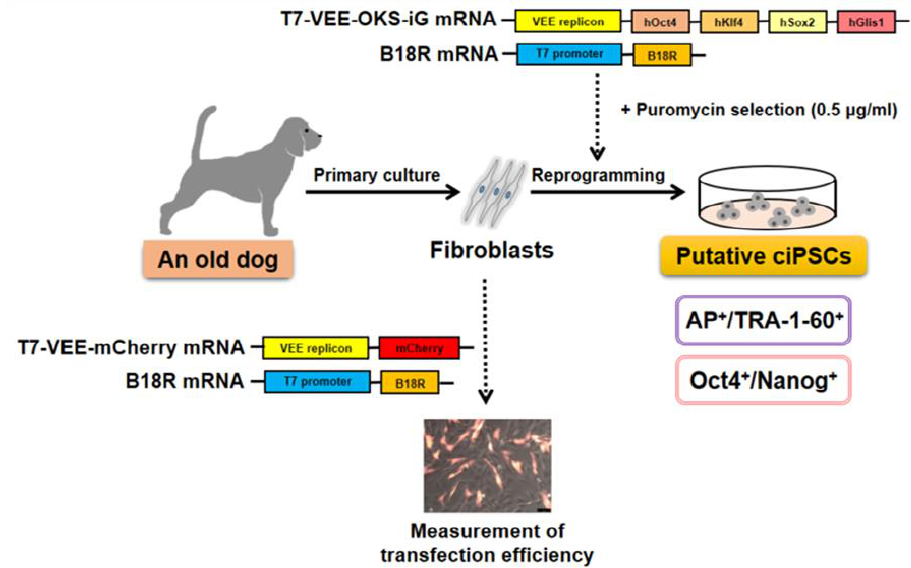
Figure 7. Schematic diagram showing the generation of putative induced pluripotent stem cells (iPSCs) from canine adult fibroblasts (CAFs) using synthetic RNAs. In this study, the fibroblasts obtained from an old dog were reprogrammed using a non-integrating VEE RNA virus replicon which has four reprogramming factors (collectively referred to as T7-VEE-OKS-iG ) and co-transfected with the B18R mRNA. To evaluate the transfection e ffi ciency, CAFs were co-transfected with T7-VEE-mCherry mRNA and B18R mRNA on day 1, using the RiboJuice™ transfection reagent. One day after the final transfection, the cells were selected with puromycin (0.5 µg/mL) until day 10. After about 25 days, the putative canine iPSC colonies were identified showing TRA-1-60 expression and alkaline phosphatase (AP) activity. Finally, the expressions of endogenous pluripotency markers such as the Oct4 and Nanog transcripts were confirmed, suggesting that the generated canine iPSCs were in the late intermediate stage of reprogramming.